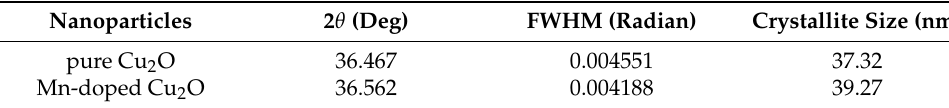
Figure 1. ( a ) XRD pattern of Cu 2 O ( b ) Mn-Cu 2 O nanoparticles. Table 1. Crystalline size of undoped and Mn-doped Cu 2 O Table 1. Crystalline size of undoped and Mn-doped Cu 2 O nanoparticles.